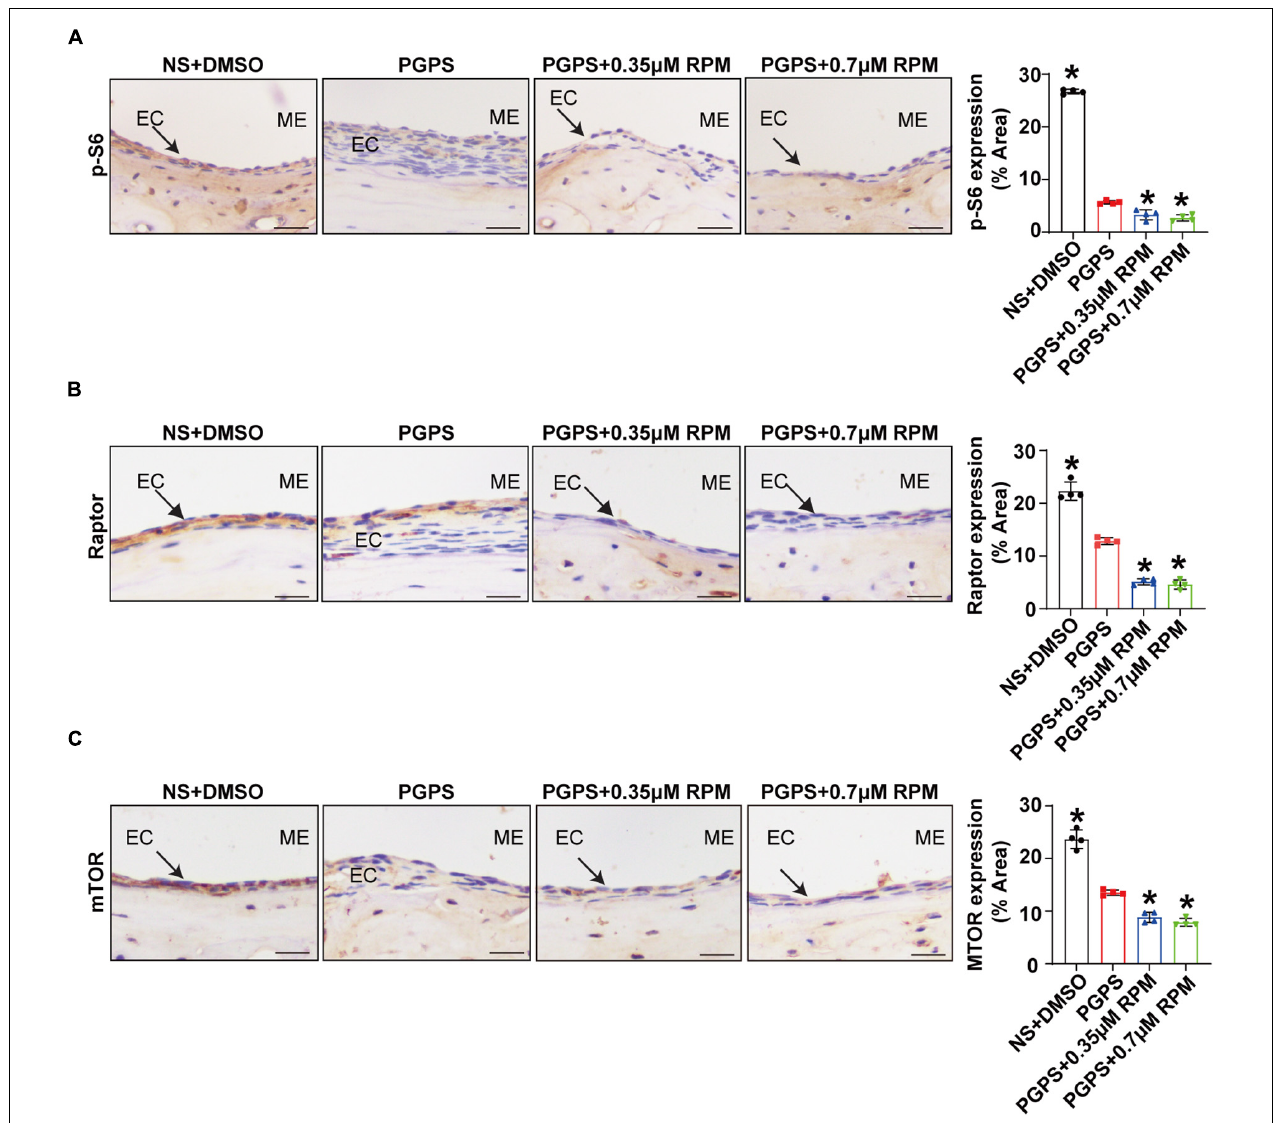
FIGURE 5 | Rapamycin treatment inhibits mTORC1 activity. Mice were inoculated with PGPS or a combination of PGPS and either 0.35 or 0.7 µ M RPM. Paraffin-embedded sections of ME tissues were immunostained antibodies. (A) The representative images and quantification of p-S6 expression in ME tissues. (B) The representative images and quantification of Raptor expression in ME tissues. (C) The representative images and quantification of mTOR expression in ME tissues. n = 4 per group. ME represents the middle ear; EC represents epithelial cells. * P < 0.05 vs. the PGPS group, one-way ANOVA, Scale bar = 25 µ